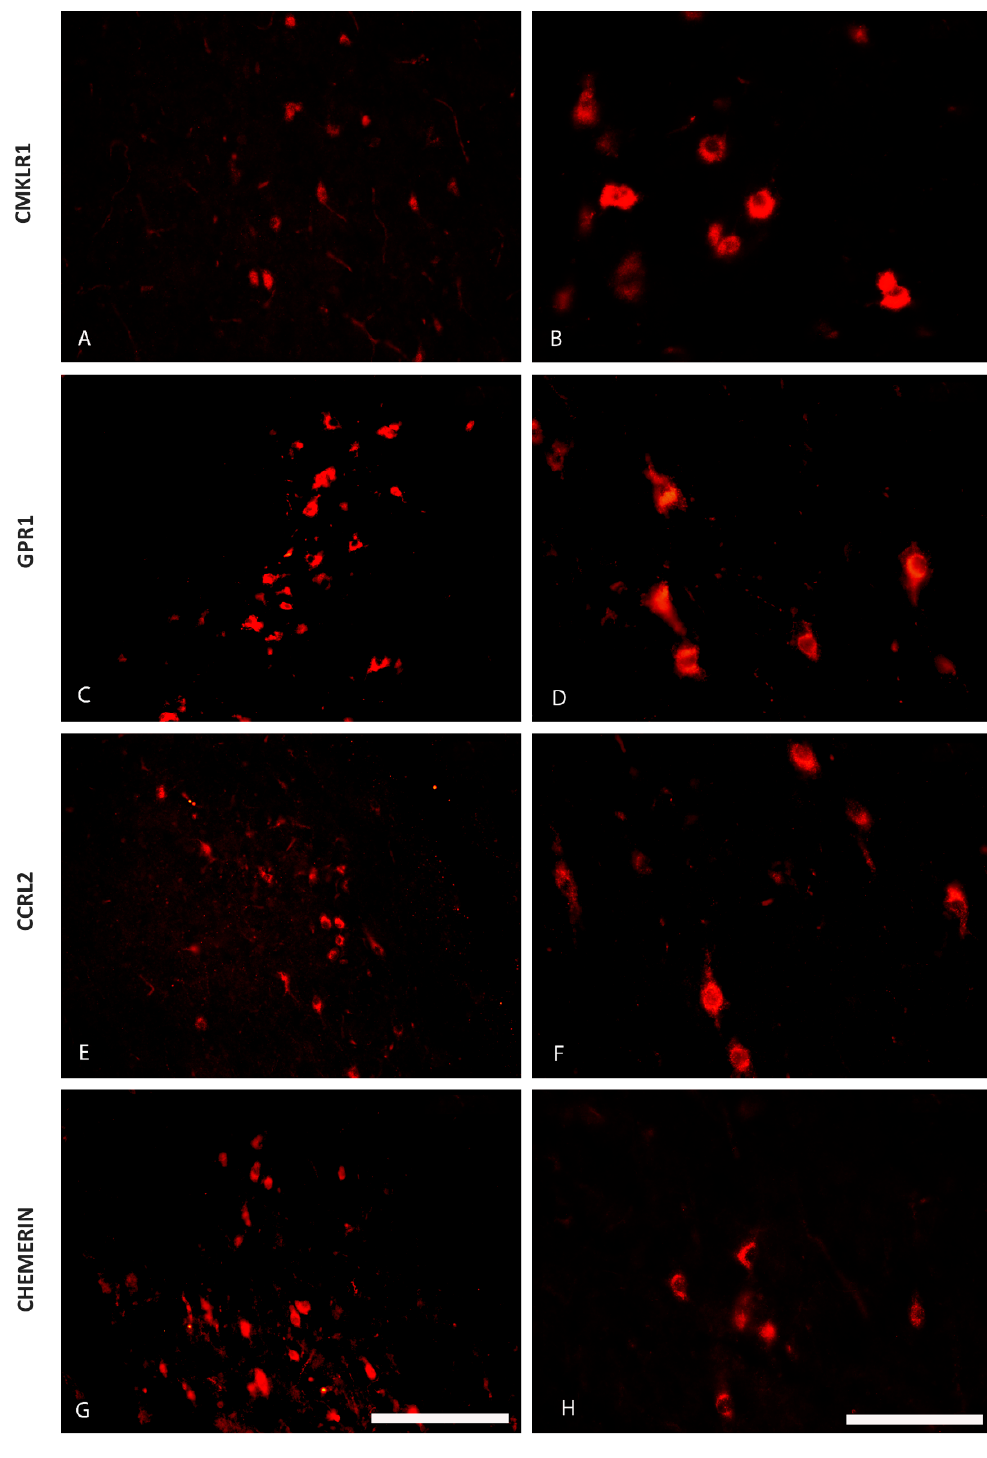
Figure 2. The distribution of the chemerin system in the porcine preoptic area (POA) during the oestrous cycle. Immunoreactivity of chemokine-like receptor 1 (CMKLR1; A and B ), G protein-coupled receptor 1 (GPR1; C and D ), C-C motif chemokine receptor-like 2 (CCRL2; E and F ) and chemerin ( G and H ) during the oestrous cycle (days 10 to 12) in the hypothalamus of the pig at the level of the preoptic area. Scale bar: 200 µm, applies to A, C, E, G; scale bar: 100 µm, applies to B, D, F, H.